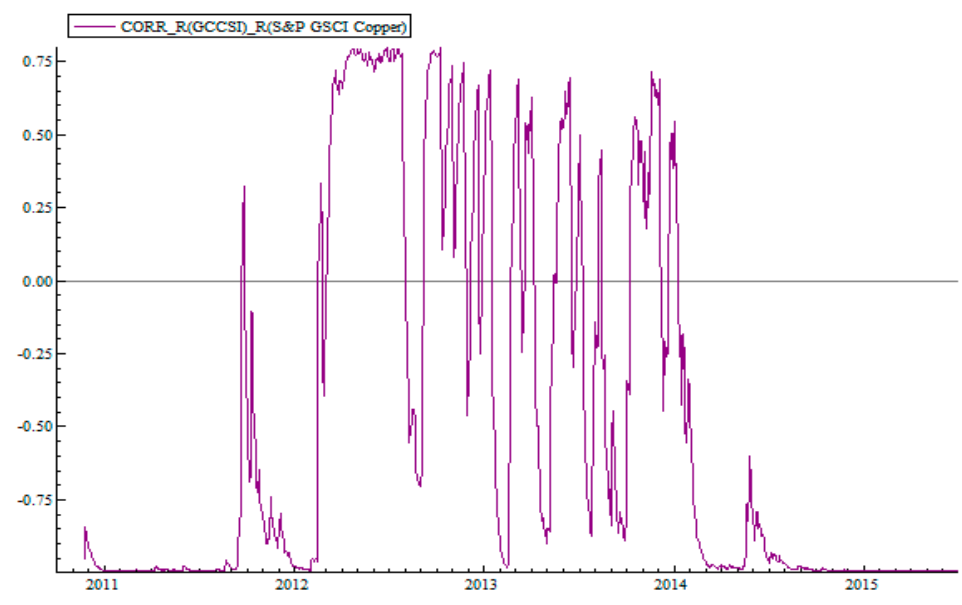
Figure 4. The evolution of the DCC behavior for panel a from 2010 to 2015.